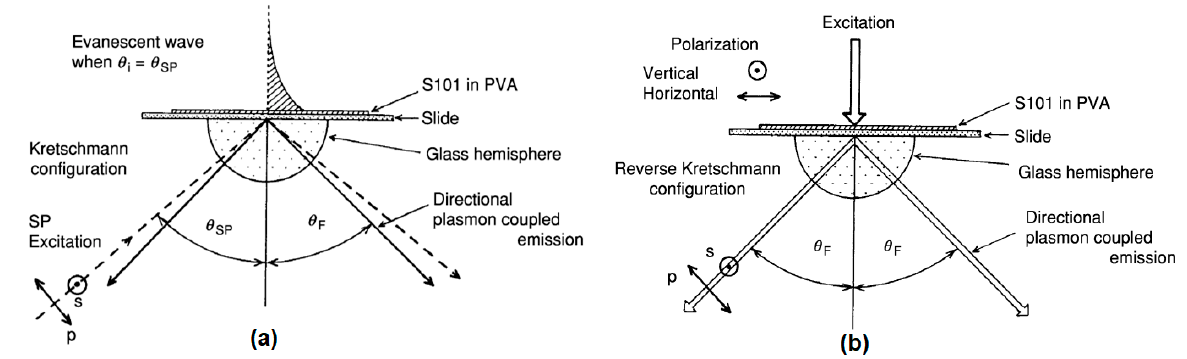
Figure 23. The excitation and emission of surface plasmon coupled emission (SPCE) in ( a ) Kretschmann (KR) configuration, ( b ) reverse Kretschmann (RK) configuration (adapted with permission from Reference [93], copyright Elsevier).